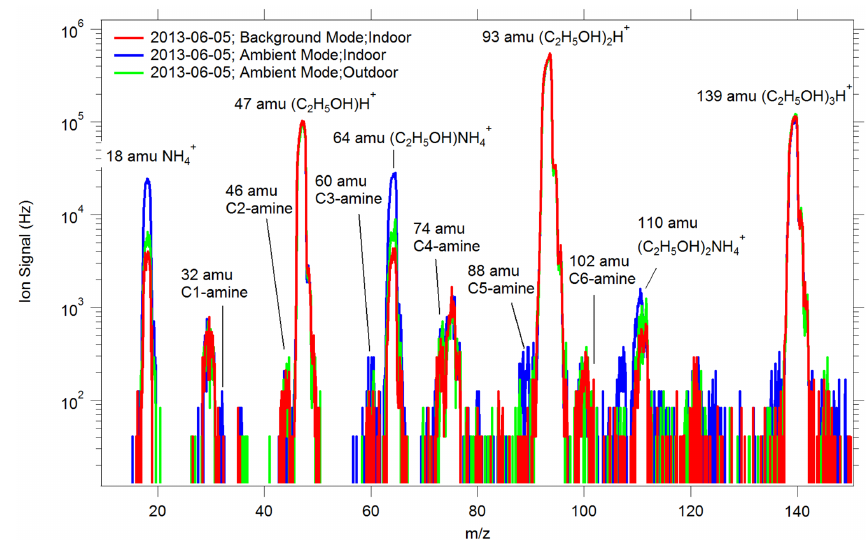
Figure 1. Typical CIMS mass spectra taken under the background (red) and measurement modes, including measurements from the ambient air (green) and indoor air (blue), in the Alabama forest. Y axis is shown in log scale. Table 1. The CIMS sensitivities (normalized to 1MHz ethanol reagent ions) determined by in situ calibrations (Fig. S1), background signals, and detection limits (3 times the standard deviation of background signals, within a 1min integration time) of amines and NH 3 . Typical ambient concentrations measured in the Alabama forest and in Kent are also included (20min average data). Basic Compound a Sensitivity Detection Limit, Alabama